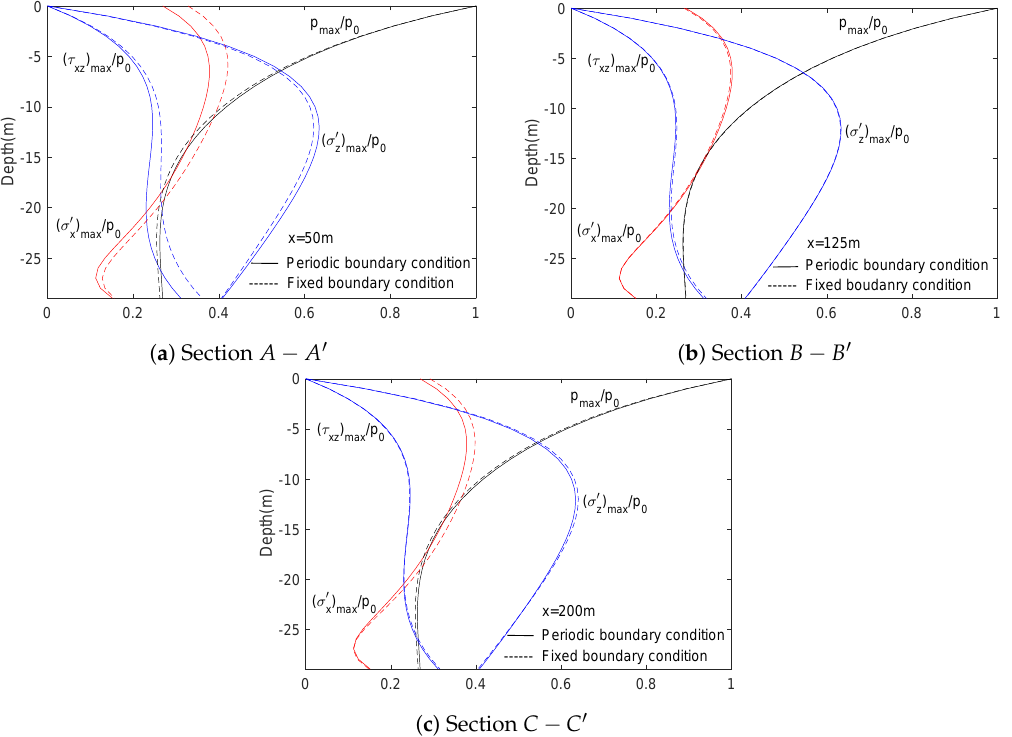
Figure 2. Comparison of wave-induced seabed response between the cases with periodic and fixed lateral